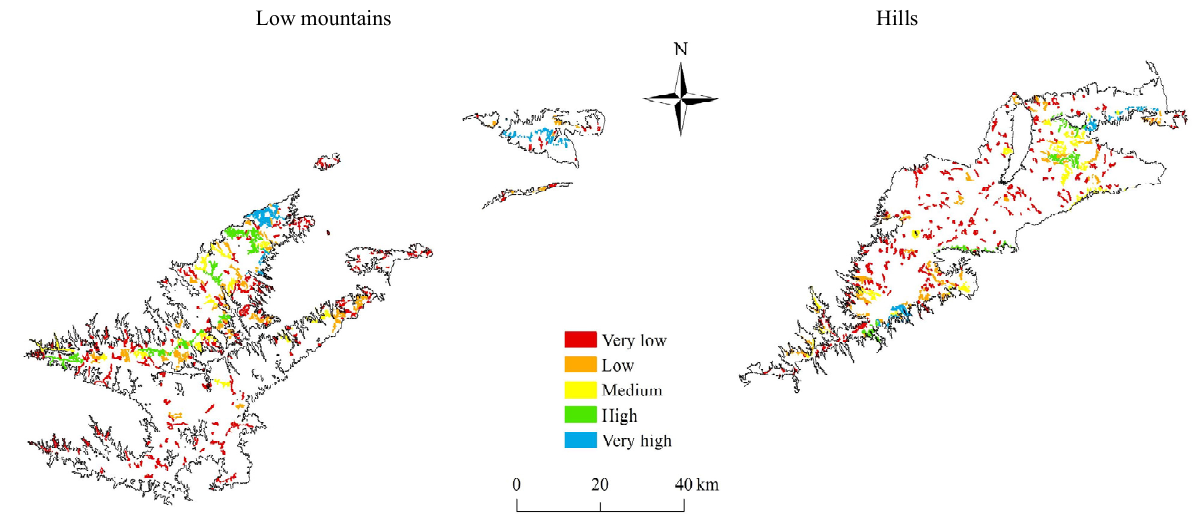
Figure 6. Contribution of reforested patches to the improvement of FLC.